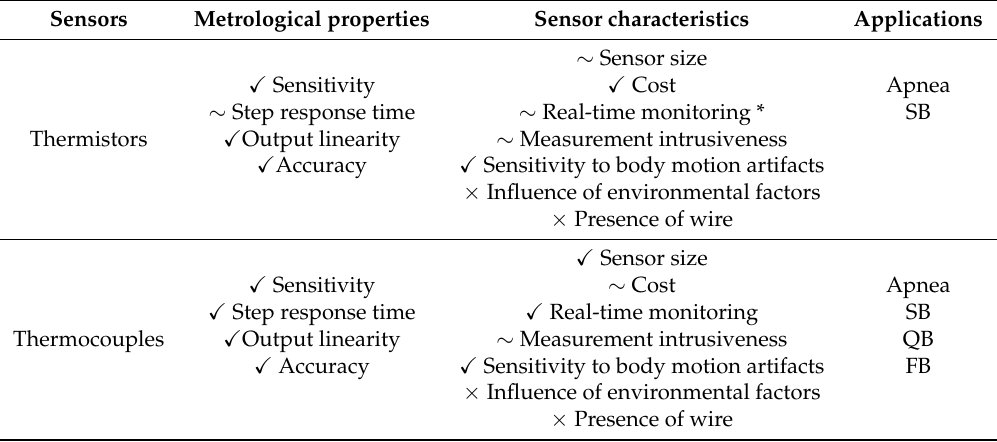
Table 3. Main metrological properties and characteristics of the temperature sensors used for f R measurement. (cid:88) good to excellent, ∼ sufficient, ×